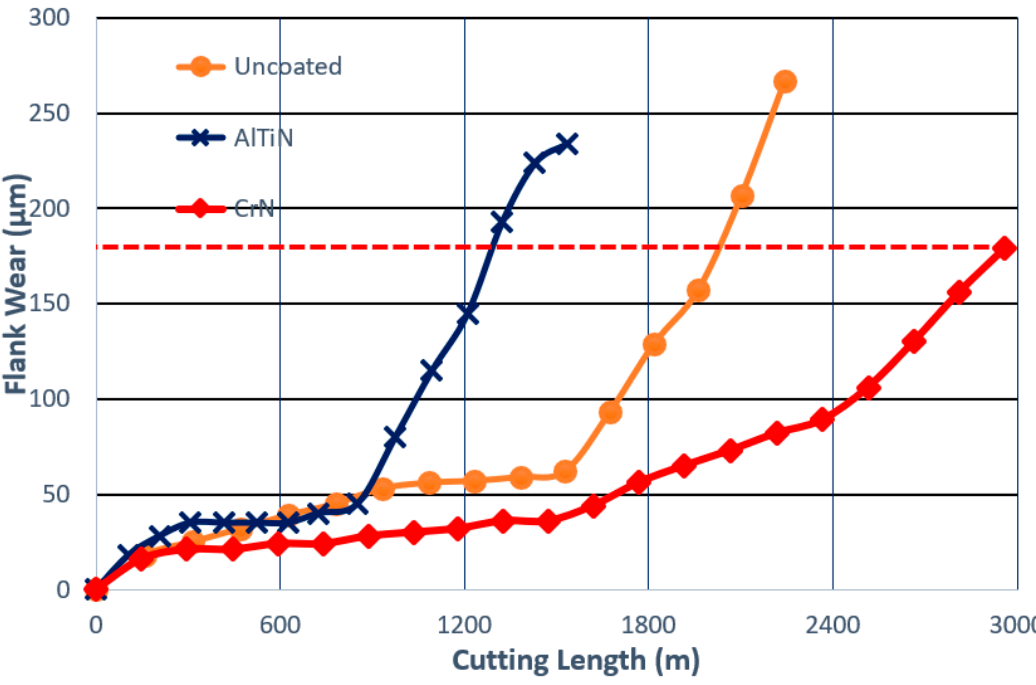
Figure 9. Flank wear vs. length of cut data under wet conditions at 150 m / min for coated and uncoated tools during finish turning of TiAl 6 V 4 alloy. Reproduced from [36], with permission from Elsevier, 2020. Two wear mechanisms are prevalent for the outlined conditions: (1) crater wear combined with (2) intensive adhesive interaction at the tool–chip interface resulting in built-up edge formation. At elevated cutting speeds, crater wear predominates on the rake face due to the generation of high